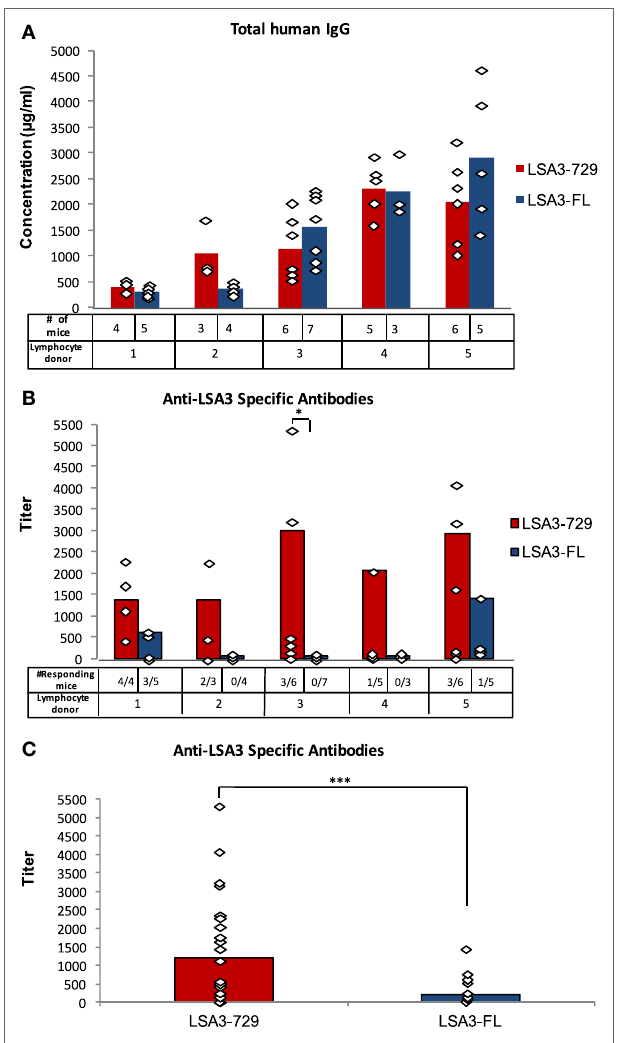
FigUre 2 | Human B cell responses elicited by liver stage antigen 3-full length (LSA3-FL) and liver stage antigen 3-729 (short form) (LSA3-729). (a) Total IgG and (b,c) LSA3-specific antibodies. NSG mice were engrafted with in vitro primed human spleen cells obtained from